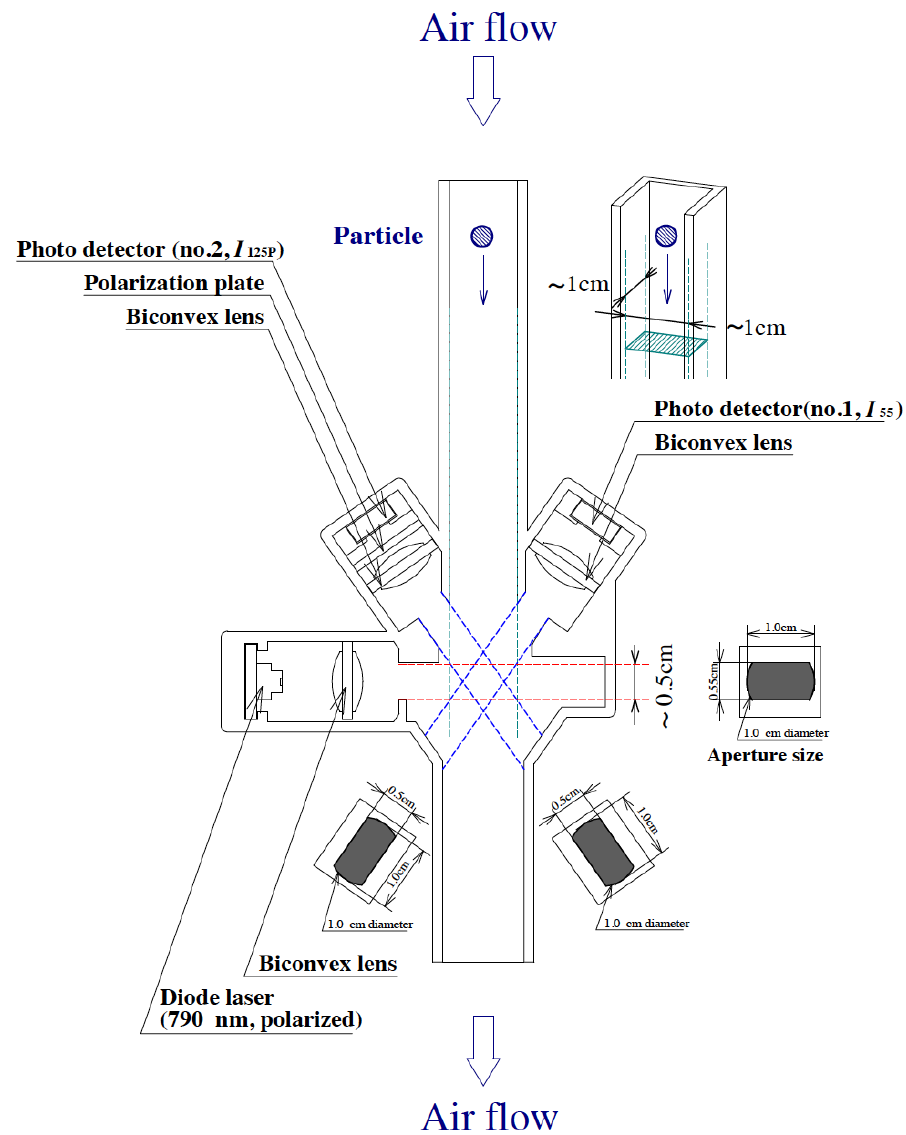
Figure 2. Schematic diagram of the CPS (from Fujiwara et al.,